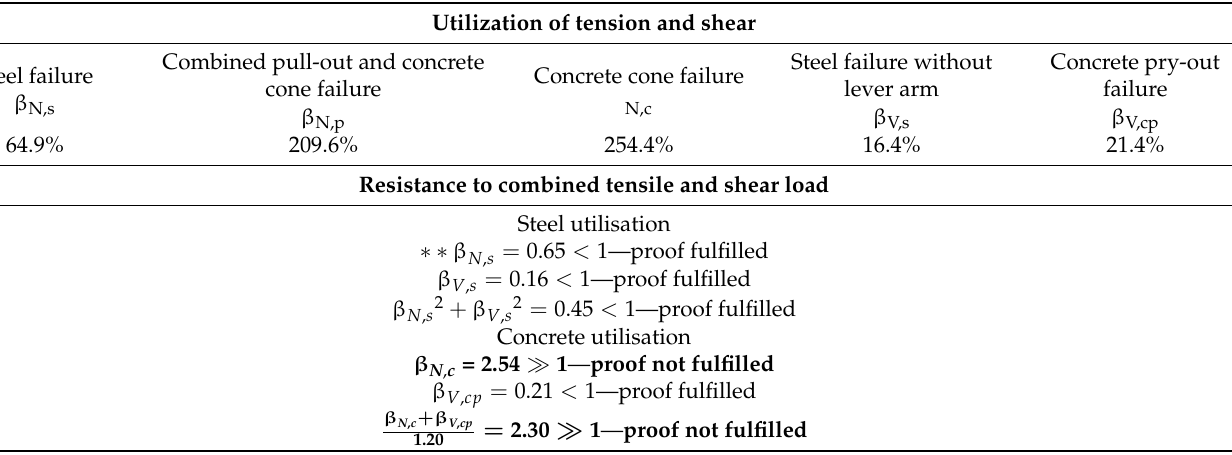
Table 4. Degree of effort of anchorage in the foundation slab of the